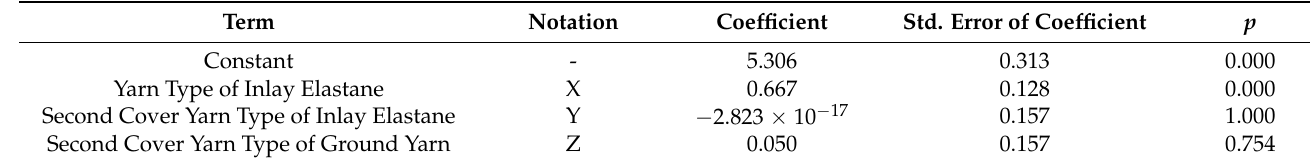
Table 4. Estimated effects of the variables on length changes.